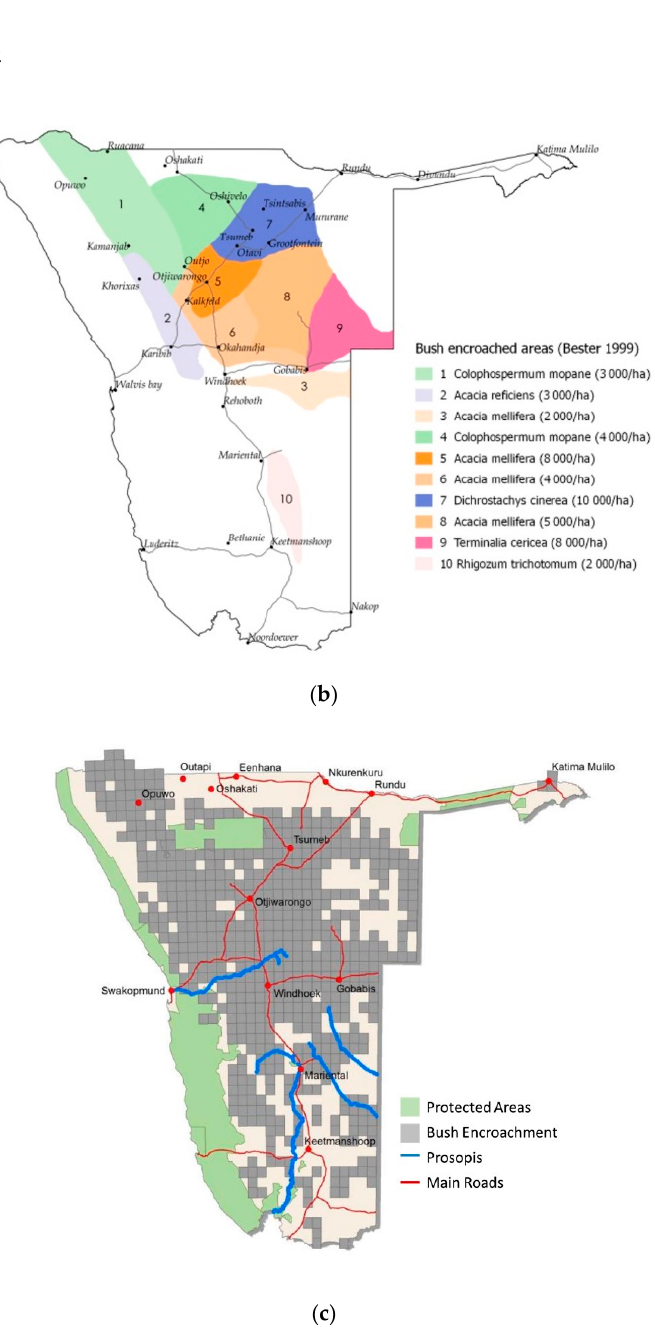
Figure 15. Comparison Land Degradation Map between 2001 and 2015. ( a ) Own calculation, ( b ) bush encroachment areas in 1999 [60], and ( c ) bush encroachment extent in 2015 [13].